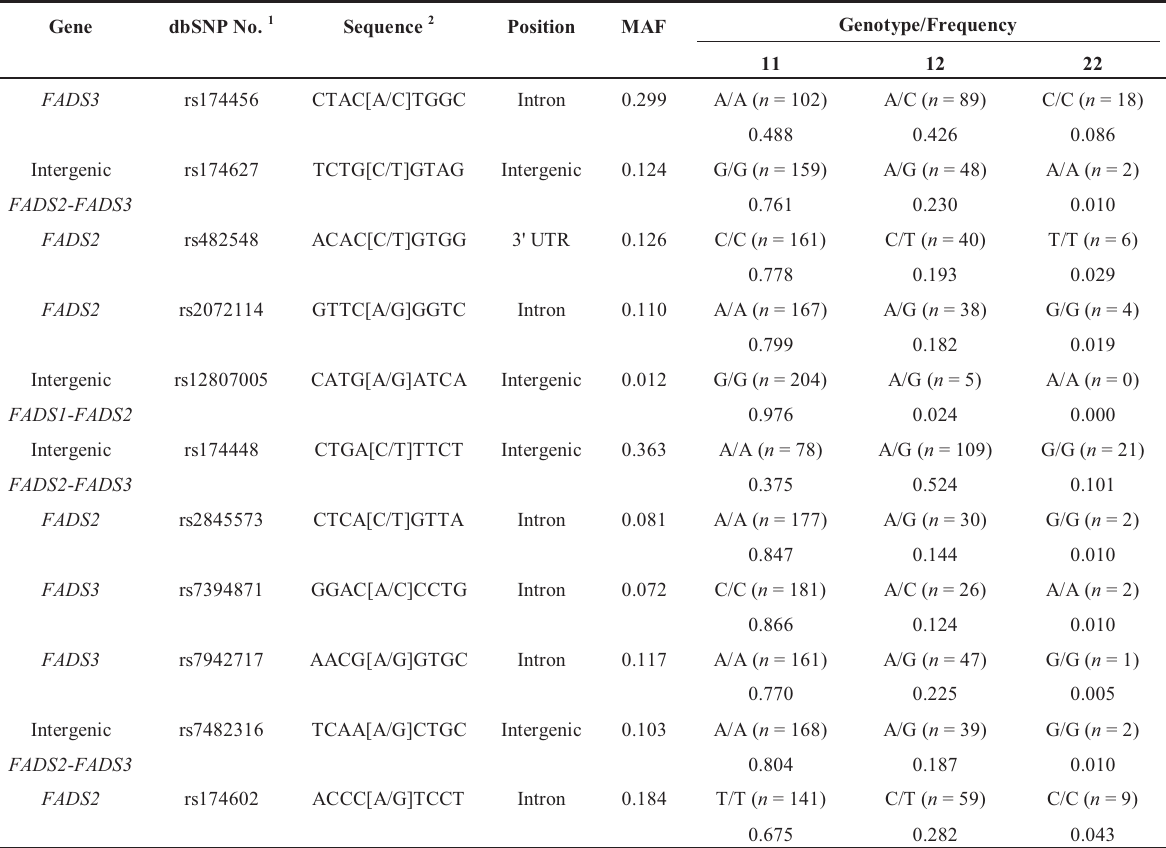
Table 4. Description of the selected polymorphisms in the fatty acid desaturase ( FADS ) gene